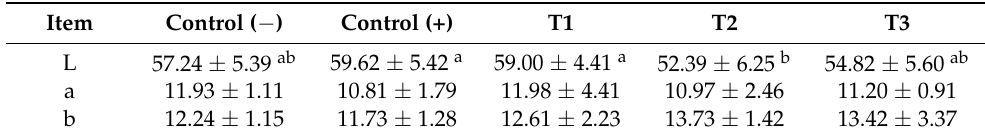
Table 6. Meat color of pork patties with fermented soy